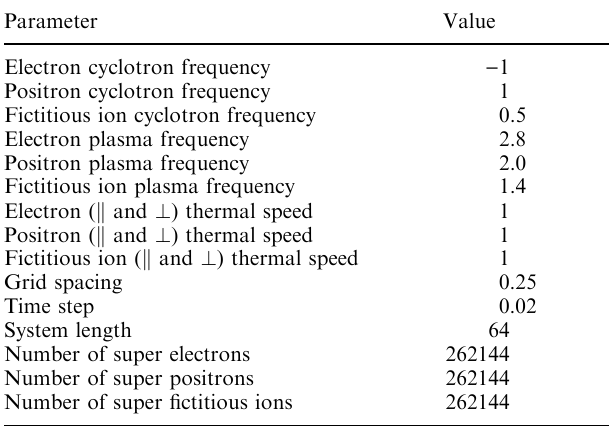
Table 1. Simulation